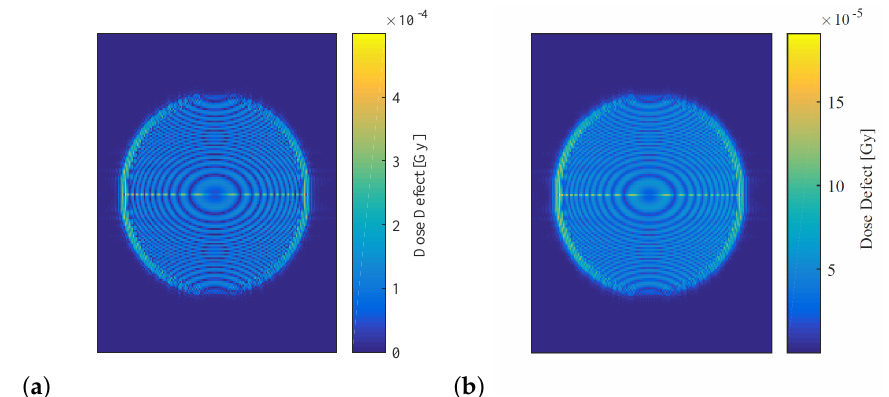
Figure 9. Dose defect maps of the simulated 1 Gy absorbed-dose phantom. ( a ) Dose defect caused by simulated atmospheric perturbation, where every parameter was set to maximise a change in refractive index. ( b ) Dose defect caused by simulated heat expansion of 5 ◦ C. Note the different scales. Table 5. Error generated by simulating atmospheric drift and heat expansion in the virtual dosimeter. Parameter Mean Dose Defect (Gy) Estimated Uncertainty (Gy) Atmospheric